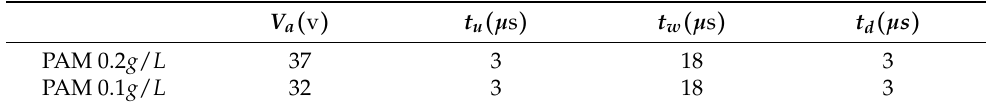
Table 4. Actuation parameters.